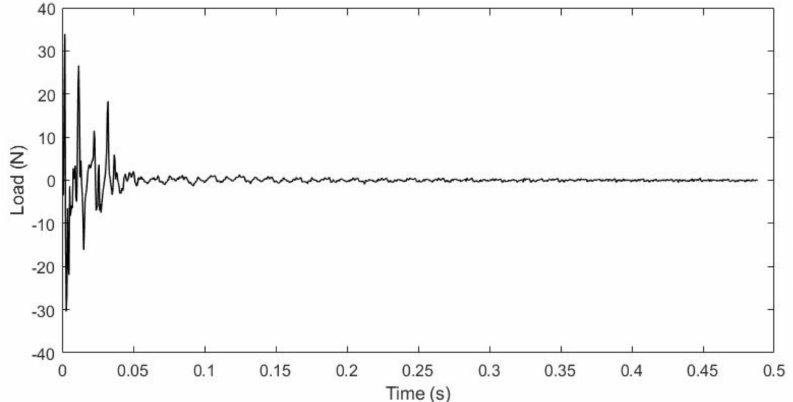
Figure 13. Dynamic load applied on the numerical